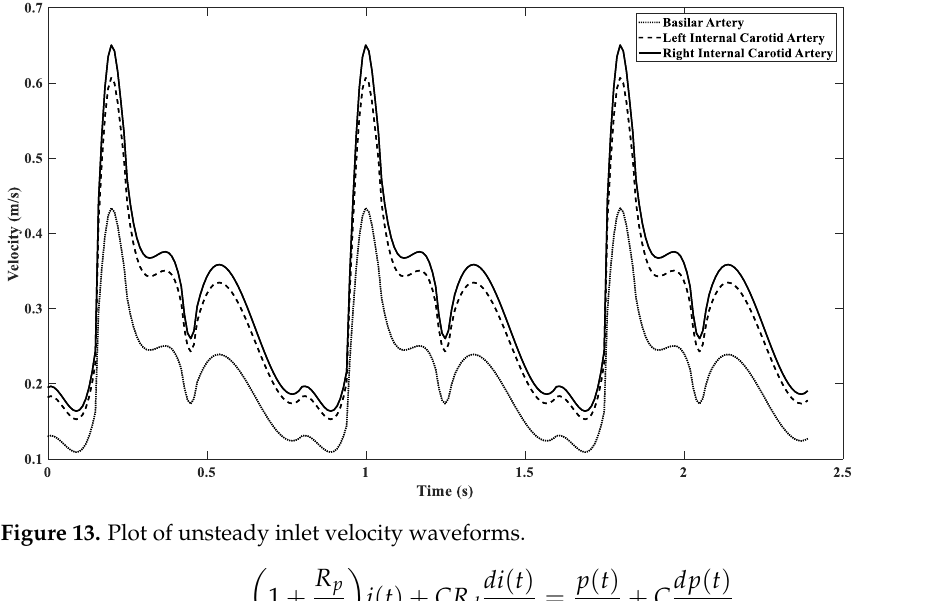
Figure 13. Plot of unsteady inlet velocity waveforms.